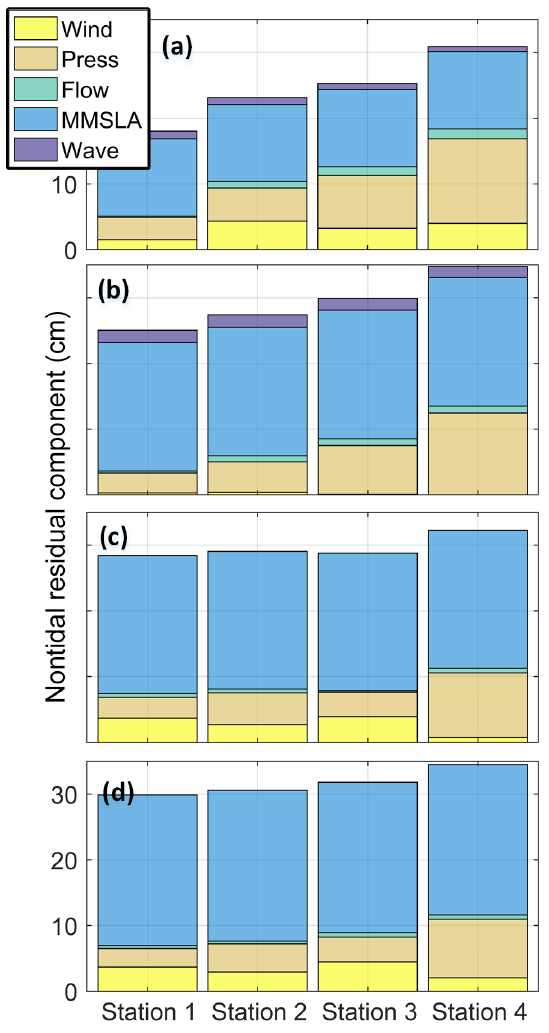
Figure 9. WL contributions from various forcings during the largest simulated WL event. Stations transition from the tide gauge (sta- tion 1) to the far river outlet of the estuary (see Fig. 3 for station locations). Panels (a) and (b) show the Coos historic and future pe- riods. Panels (c) and (d) show the Tillamook historic and future periods. All panels have the same y -axis